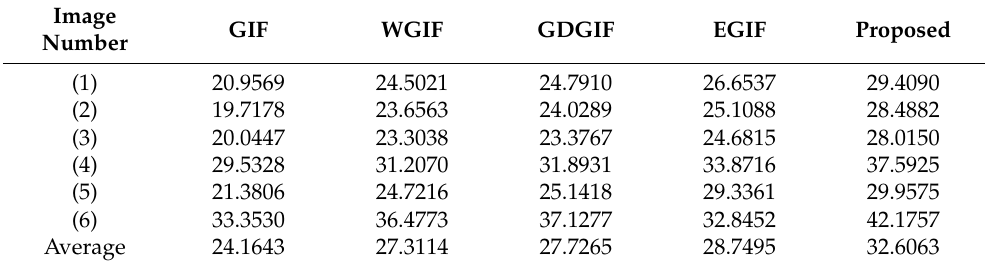
Table 1. PSNR calculation results.